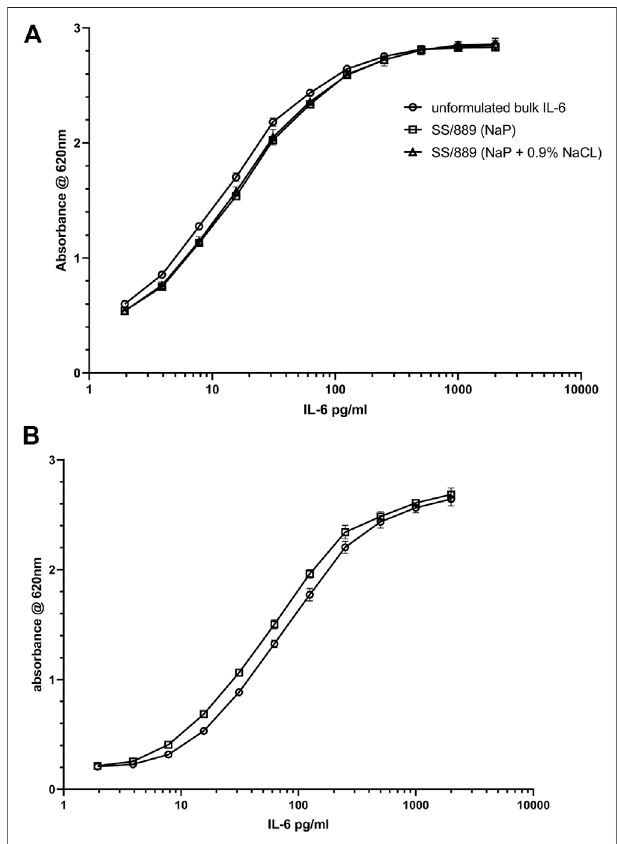
FIGURE 6 | Bioactivity of IL-6 samples (A) (IL-6 trial SS-889) in NaP formulation with (open triangle) and without (open square) addition of 0.9% NaCl, compared withIL-6 unformulatedbulk material (opencircle) inthe HEK- Blue ™ IL-6 reporter gene assay and (B) bioactivity of the IL-6 candidate preparation21/308(opensquare)comparedtotheinternationalstandardIL-6 89/548 (open circle) in the HEK-Blue ™ IL-6 reporter gene